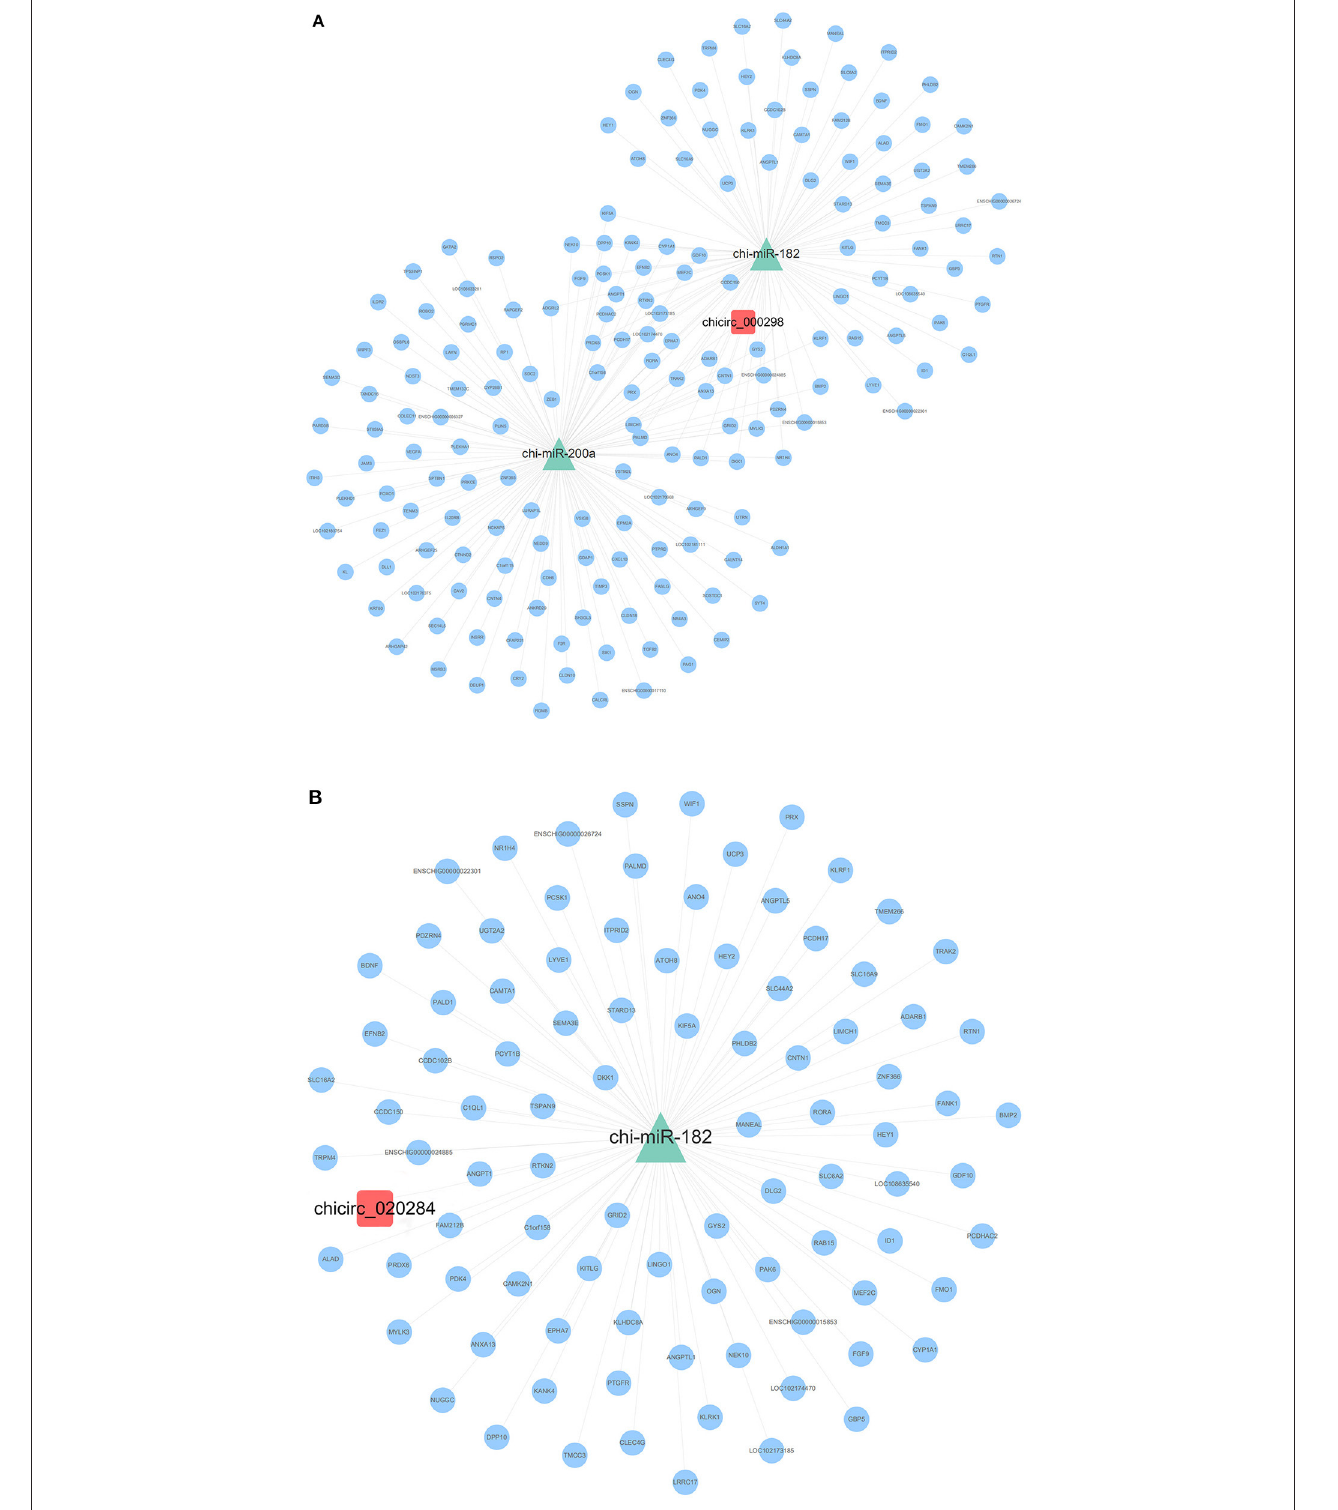
FIGURE 5 | The ceRNA network of the four downregulated (A–D) and one upregulated (chicirc_04689) (E) circRNA molecules. Red squares, green triangles, and blue circles indicate the differentially expressed circRNA, miRNA, and mRNA molecules, respectively.